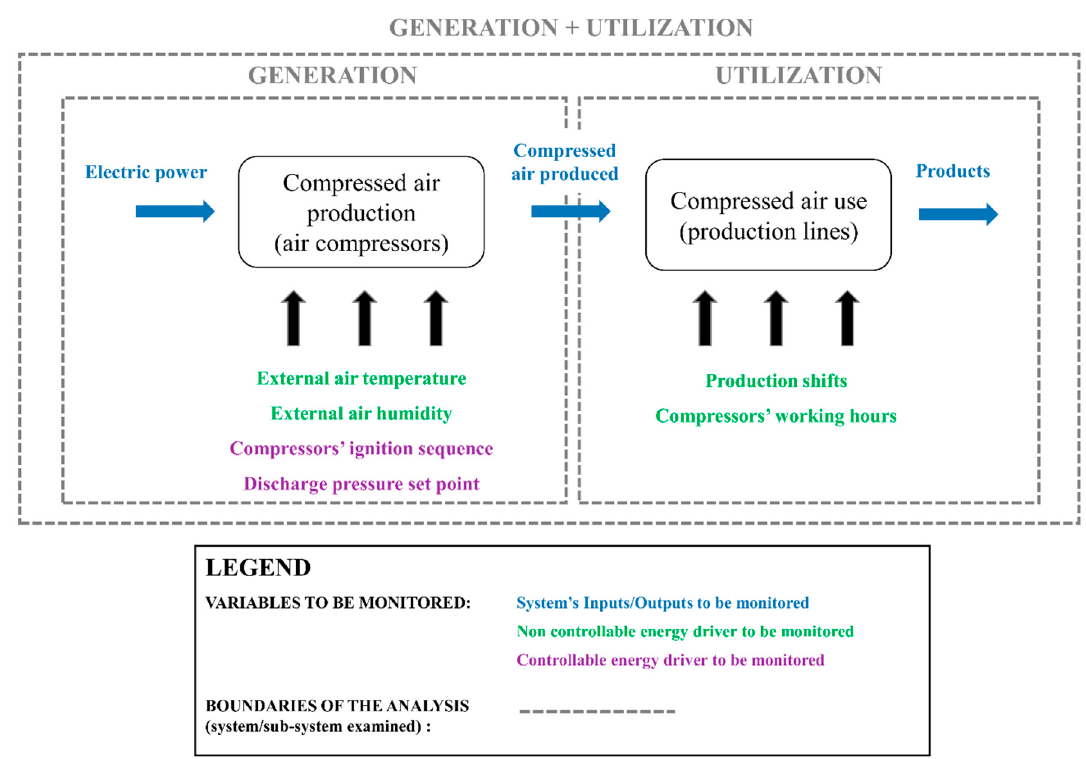
Figure 1. Schematic representation of the most common variables to be monitored for compressed air systems (CAS) and of the different boundaries of the analysis.